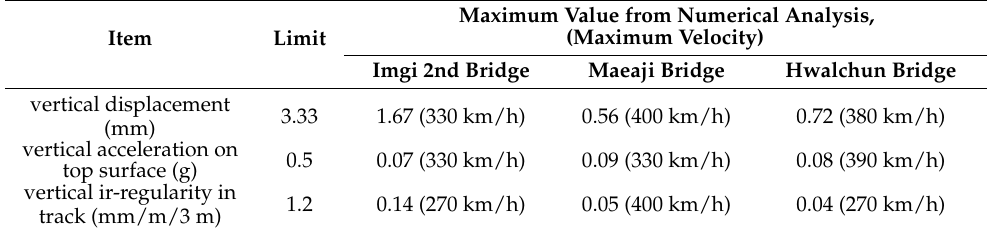
Figure 9. Dynamic stability of the target bridges according to the train speed: ( a ) Imgi 2nd Bridge; ( b ) Maeaji Bridge; ( c ) Hwalchun Bridge. Table 8. Dynamic stability criteria for the target bridges and the results of analysis.